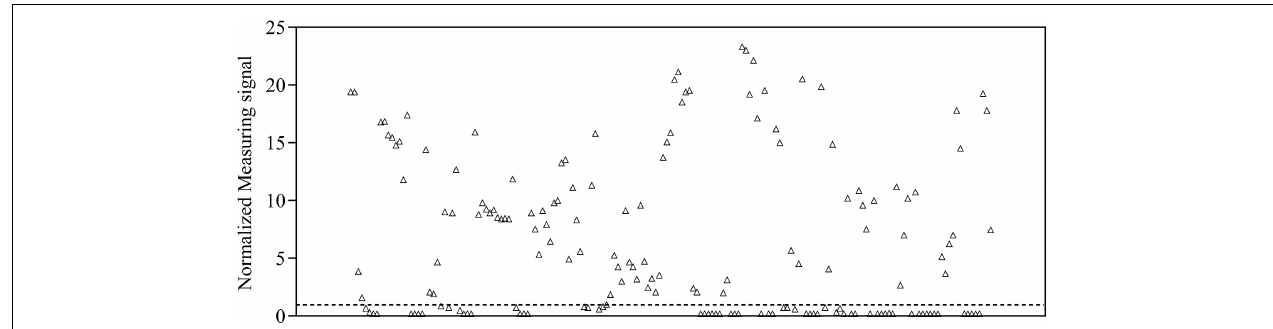
FIGURE 1 | Normalized measuring signals of 170 sera samples derived from patients hospitalized in the University Hospital RWTH Aachen using DiaSorin Liaison SARS-CoV-2 S1/S2 IgG test kit in clinical environment. Each data point represents one patient ( n = 1). Dashed line indicates the threshold defining whether antibodies are present in patient’s sample or